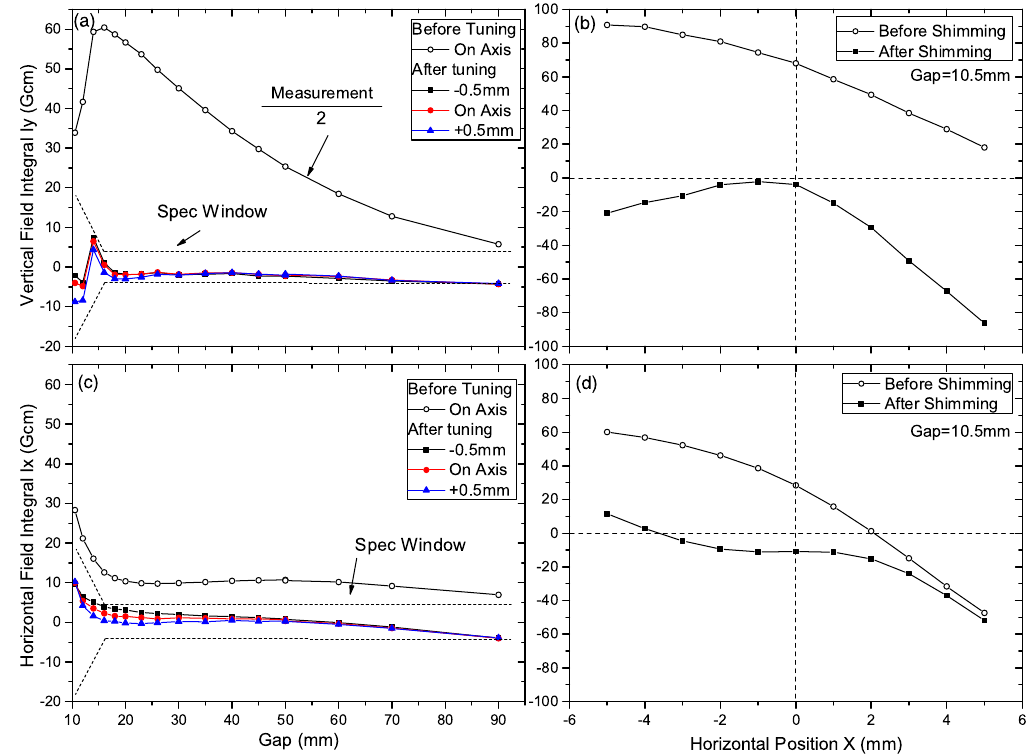
FIG. 8. Demonstration of the tuning of the vertical field integrals. Left: Open symbols, status as found; full symbols, field integral after tuning. Red: On-axis measurement; blue, black measurement at x ¼ (cid:1) 0 . 5 mm. All curves fit inside the specs window as given by Table I, which is indicated for comparison. Right: Gradient optimization is demonstrated by the slope of the x dependence at the 10.5 mm gap before and after